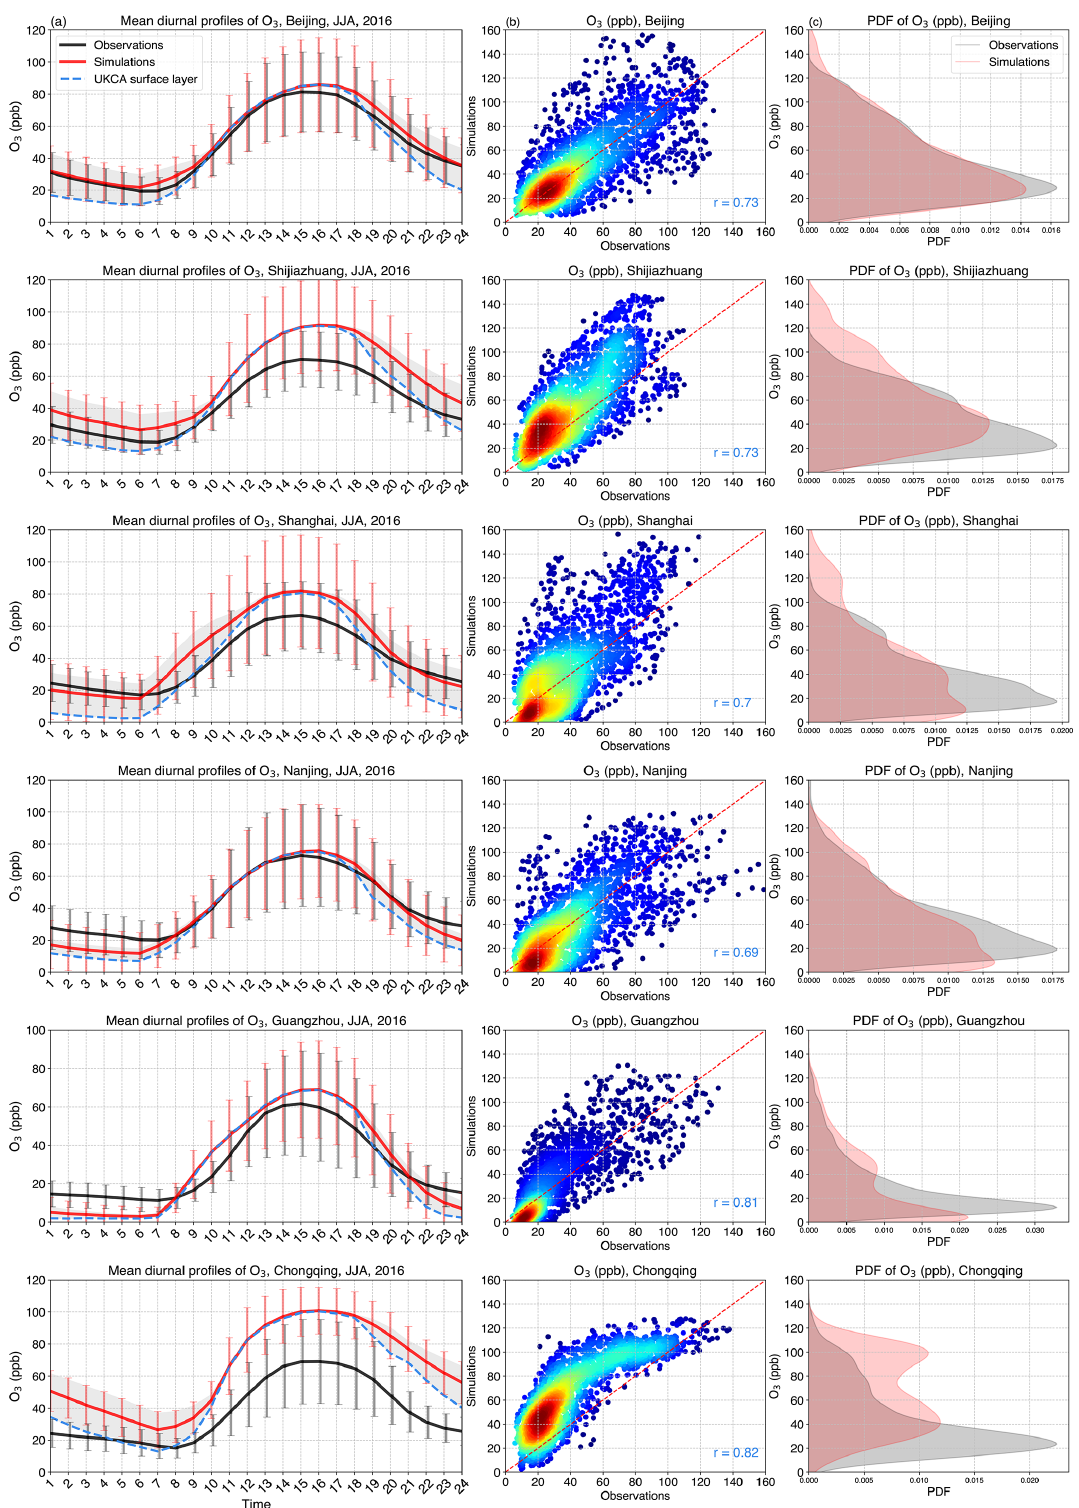
Figure 3. Comparison of observed and modelled O 3 concentrations for the six industrialised regions in JJA, 2016, China. (a) Mean diurnal cycles of observed and modelled O 3 concentrations (ppb). The shaded area represents the spread across the lowest three model layers. Error bars denote 1 standard deviation of hourly O 3 concentrations across all days. (b) Observed and modelled hourly O 3 concentrations (ppb; three lowest model layers) and correlation coefficient values r . (c) Probability density function (PDF) of O 3 concentrations (ppb) for modelled and observed hourly